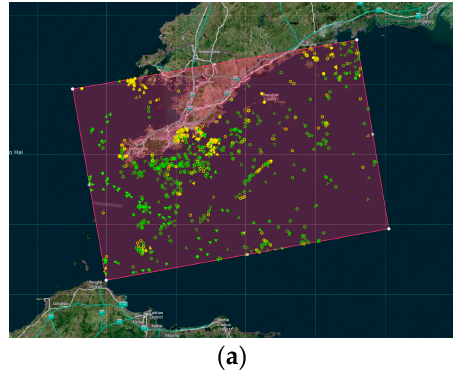
Figure 14. AIS query and Google Earth correction (take No.1 Sentinel-1 image as an example). ( a ) AIS information of the coverage. Marks of different shapes and colors represent different types of ships; ( b ) corresponding Google Earth image.